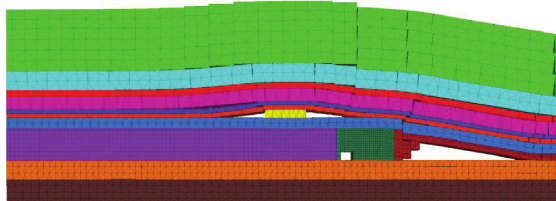
Figure 8: Overlying rock migration during the formation of the old roadway.